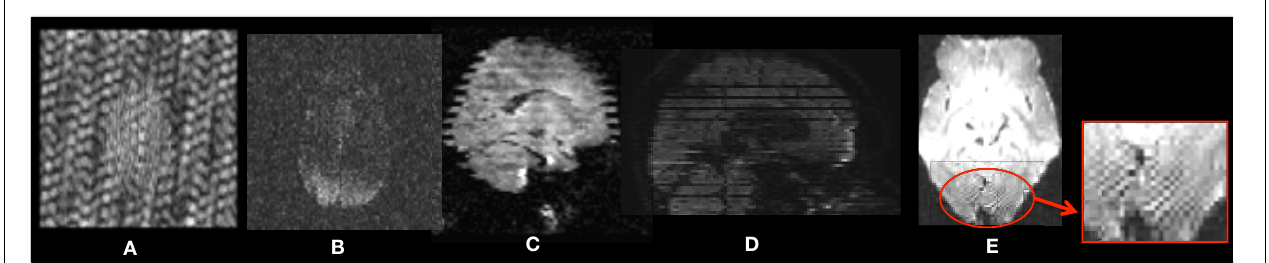
FIGURE 1 | Examples of intensity artifacts detected with DTIPrep. (A) An electromagnetic interference-like artifact, (B) severe signal loss in the anterior and middle regions, (C) venetian blind artifact, (D) inter-slice and intra-slice intensity artifact, and (E) checkerboard